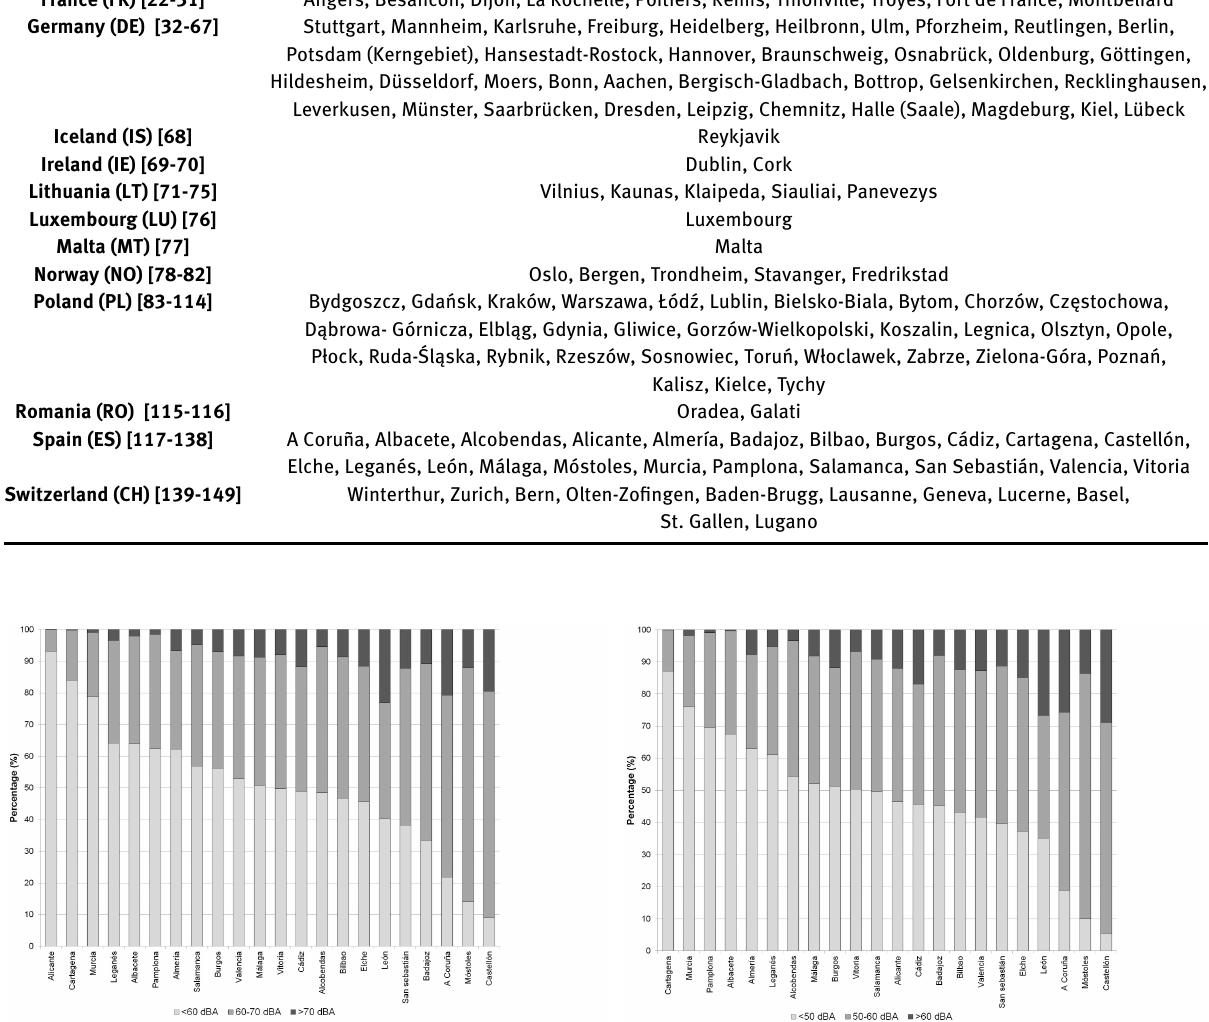
Figure 1: Percentage of people affected by traflc noise ( L den ) in the Spanish agglomerations, arranged in ascending order of proportion of people affected by Lden > 60 dBA.